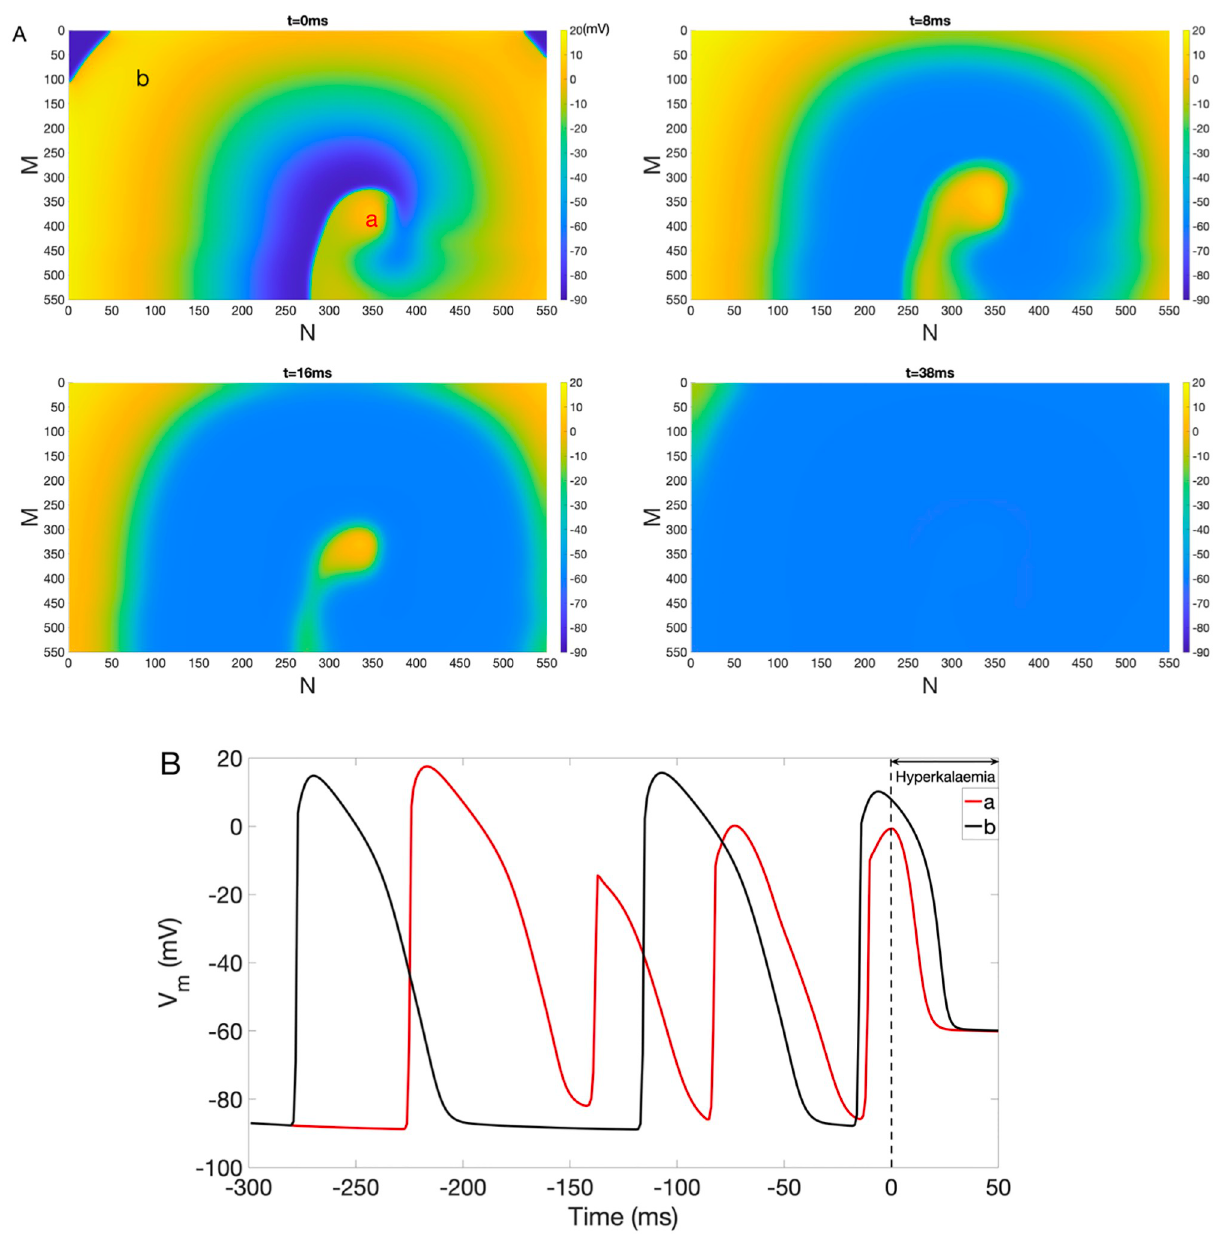
Fig 6. Inhibition of reentry under hyperkalaemia. (A) Suppression of reentry under the hyperkalaemia condition. Colorbar indicates V of mV). Snapshots of V at time = 0 ms, 8 ms, 16 ms and 38 ms are shown. (B) Representative V m